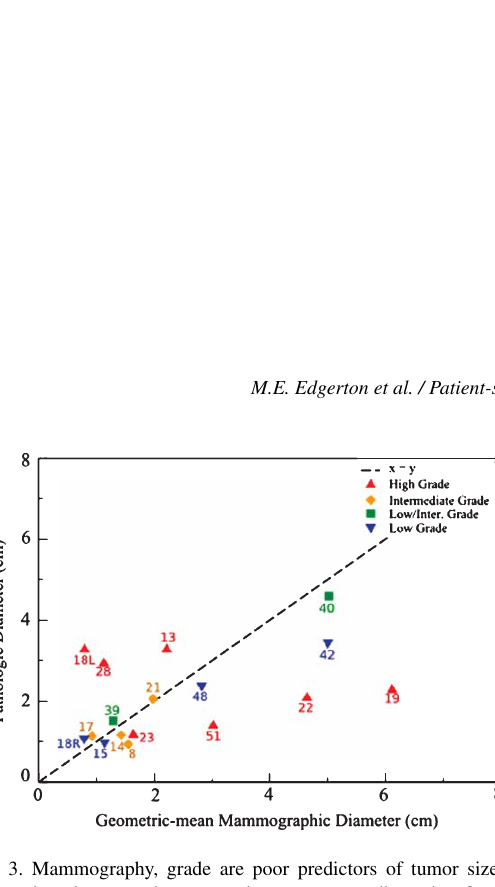
Fig. 3. Mammography, grade are poor predictors of tumor size. Comparison between the geometric-mean tumor dimension from mammograms and from pathology analysis of 17 excised DCIS tumors (de-identified case numbers are reported). Mammography overestimates tumor size in ten cases and underestimates the other seven. Correlations of both the mammography and the nuclear grade (in legend) with the tumor sizes are poor at best.